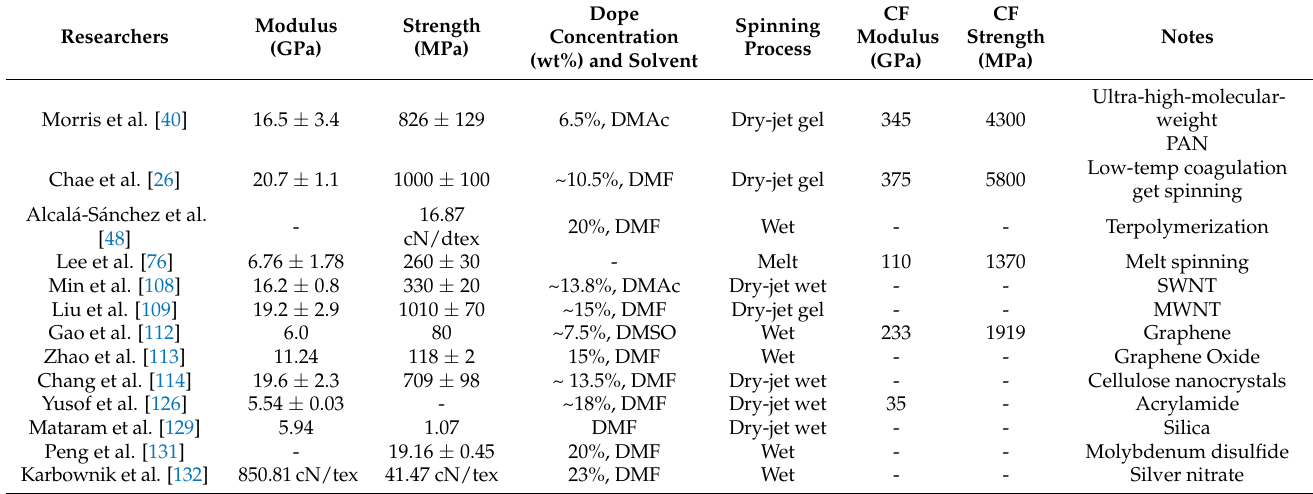
Table 1. Representative mechanical properties of PAN precursor fiber (DMAc: dimethylacetamide; DMF: N , N -dimethyl formamide; DMSO: dimethyl sulfoxide; SWNT: single-wall carbon nanotube; MWNT: multiwalled carbon nanotubes).